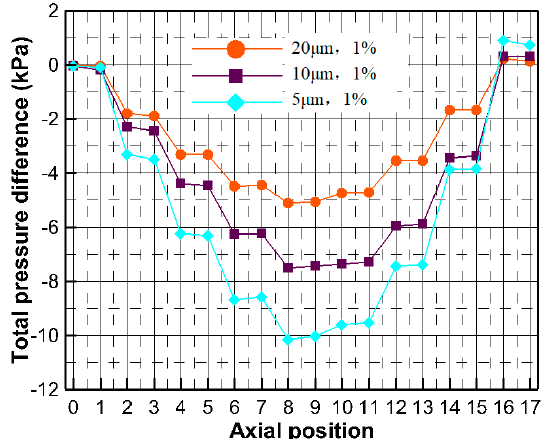
Figure 29. Axial variation of total pressure difference under injecting water of different droplet sizes. Energies 2018 , 11 , x FOR PEER REVIEW